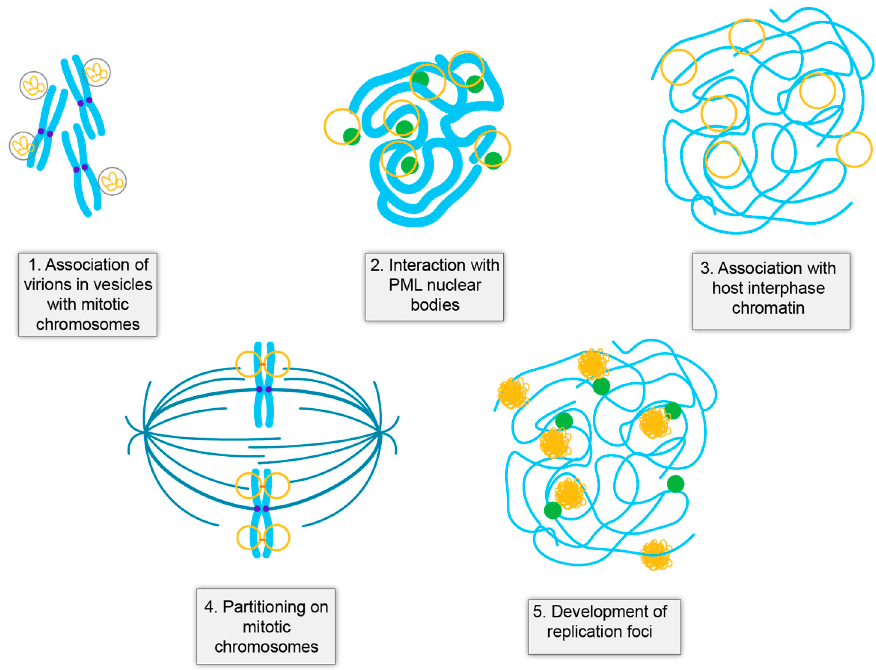
Figure 2. Close association of viral and host DNA in the HPV Infectious Cycle. Shown are five stages of the infectious cycle where there is a close juxtaposition of viral DNA (yellow) and host DNA (cyan). PML-nuclear bodies are shown in green, cohesin (orange), and the spindle (teal).